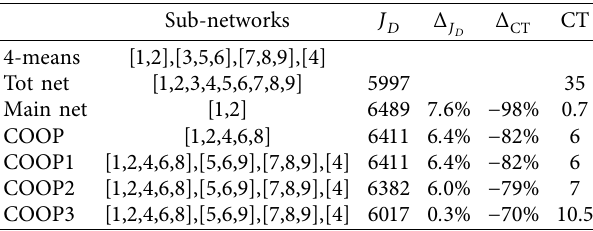
Table 3: Decentralized vs centralized with 4-means inflow decomposition.